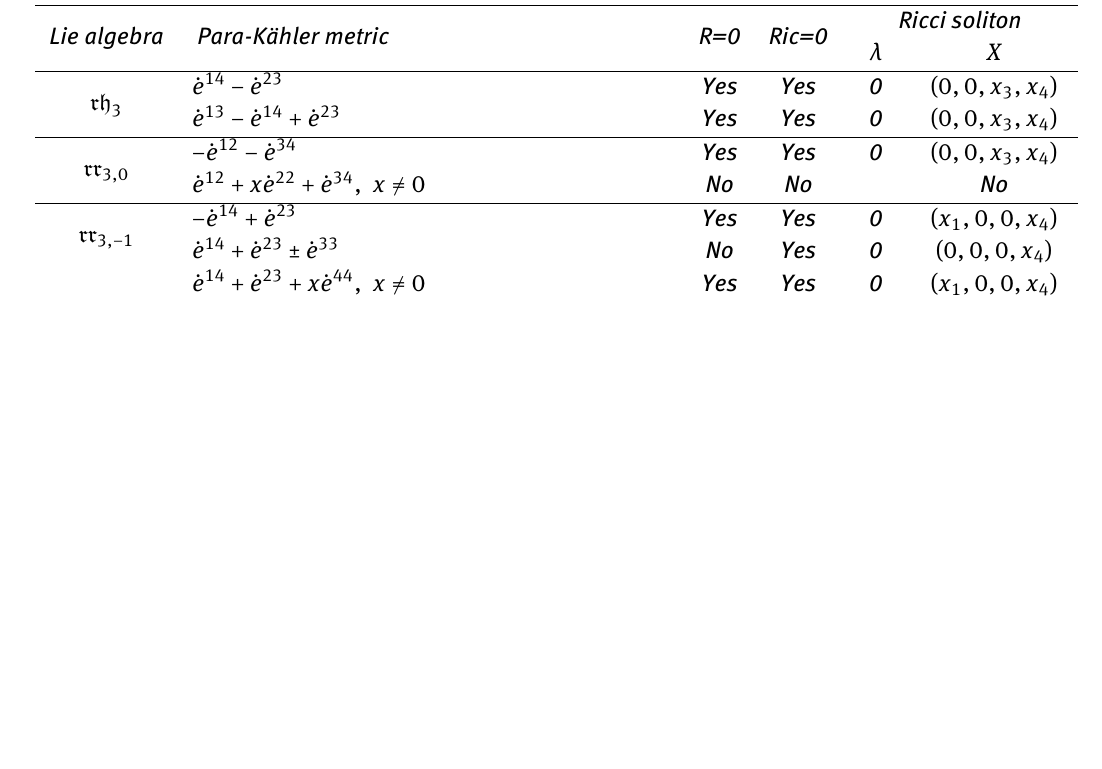
Ricci soliton λ X No No No (0, 0, 0, x 4 )